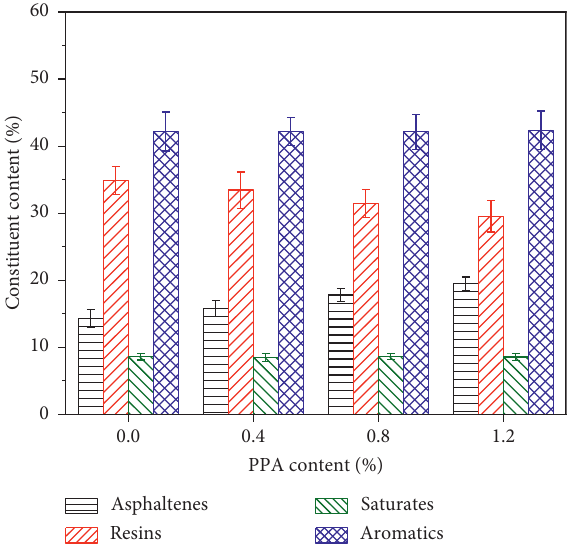
Figure 6: Effect of PPA content on the four-component results of asphalt.